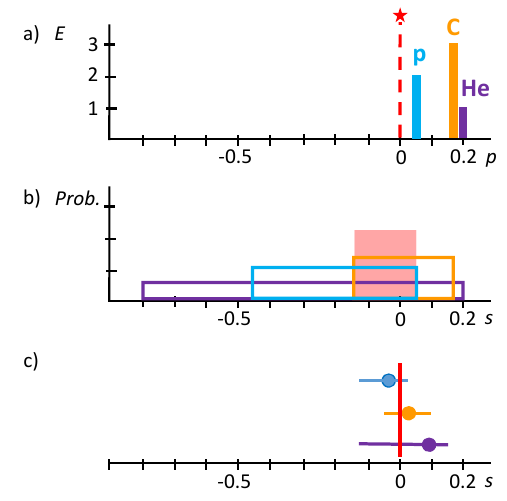
Figure 2. Reconstruction ansatz of a common source from three cosmic rays for the mixed composition case, a) true source with proton, helium and carbon nuclei, b) overlap window from maximum possible charges and corresponding deflections, c) weighted average source position from individual cosmic ray charge